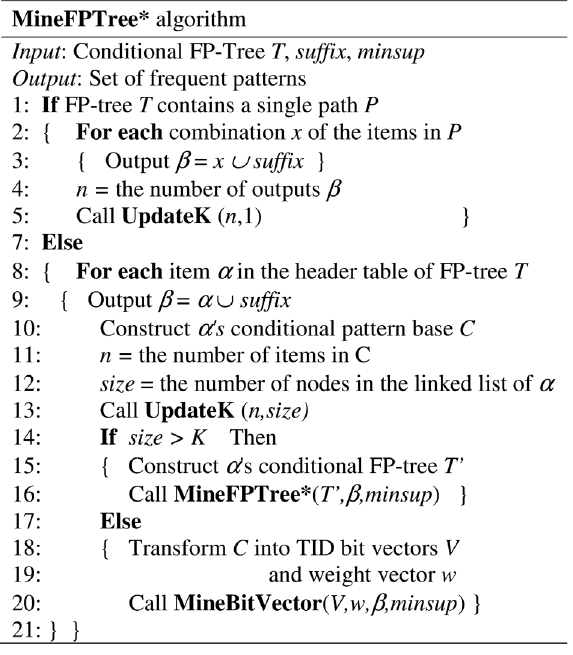
Figure 11. MineFPTree*